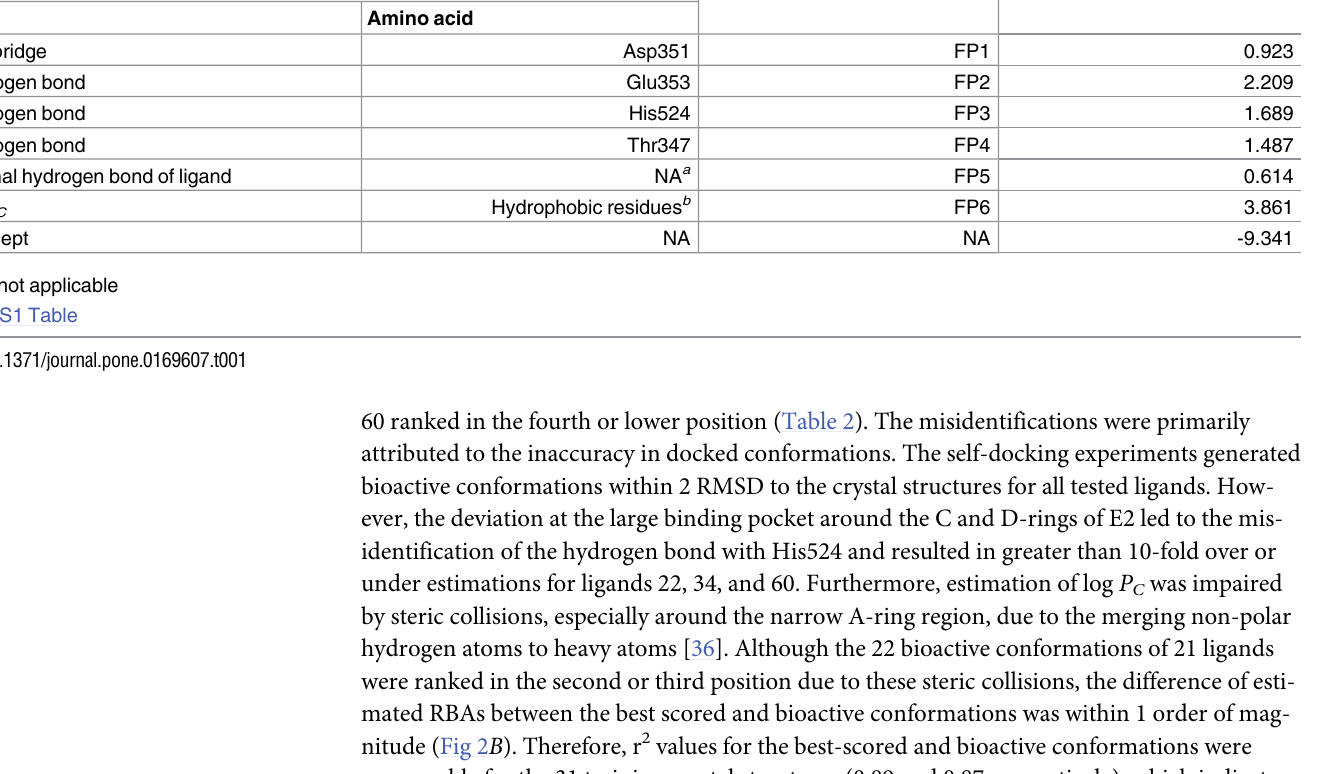
Table 2. Accuracy as rank of binding mode prediction based on the 3D-QSAR combined with self- docking or cross-docking.